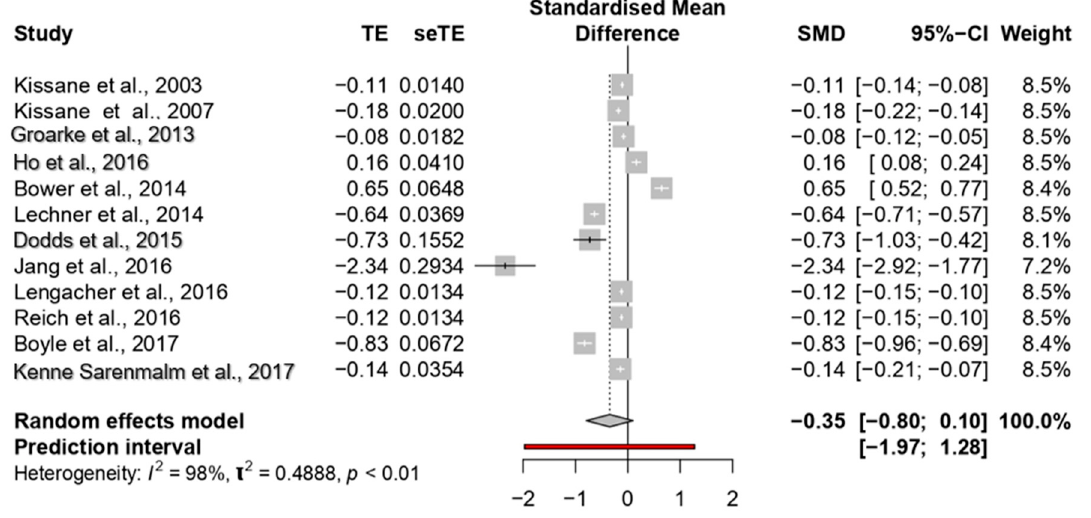
Figure 4. Forest plot of the studies considering psychological interventions focused on reducing